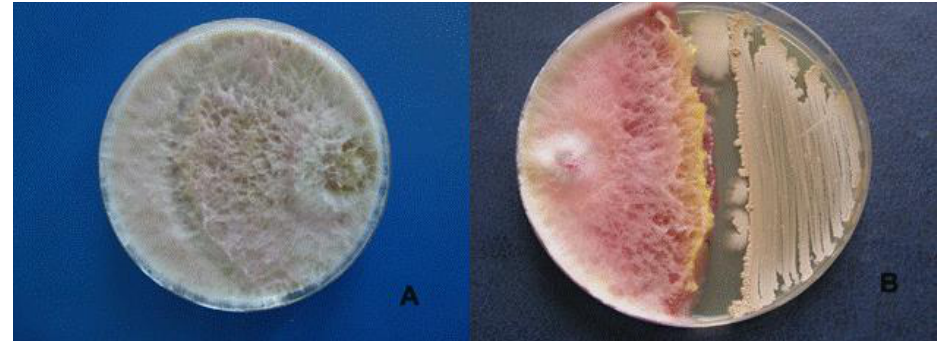
Figure 3. Antagonistic effect of Bacillus velezensis BZR 86 on Fusarium graminearum. ( A )—control, ( B )— Bacillus velezensis BZR 86.